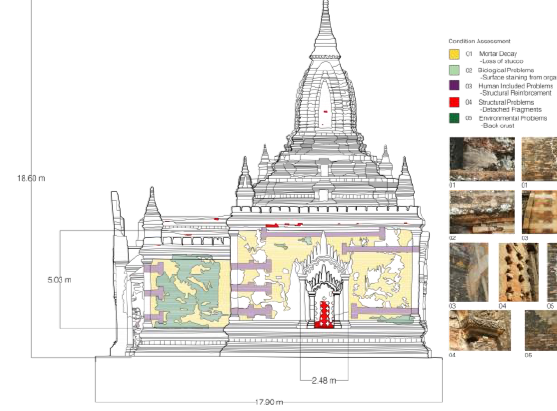
Figure 8 Example of the developed condition assessment on the West façade of the Loka-hteik-pan temple. Image source: Davide Mezzino.